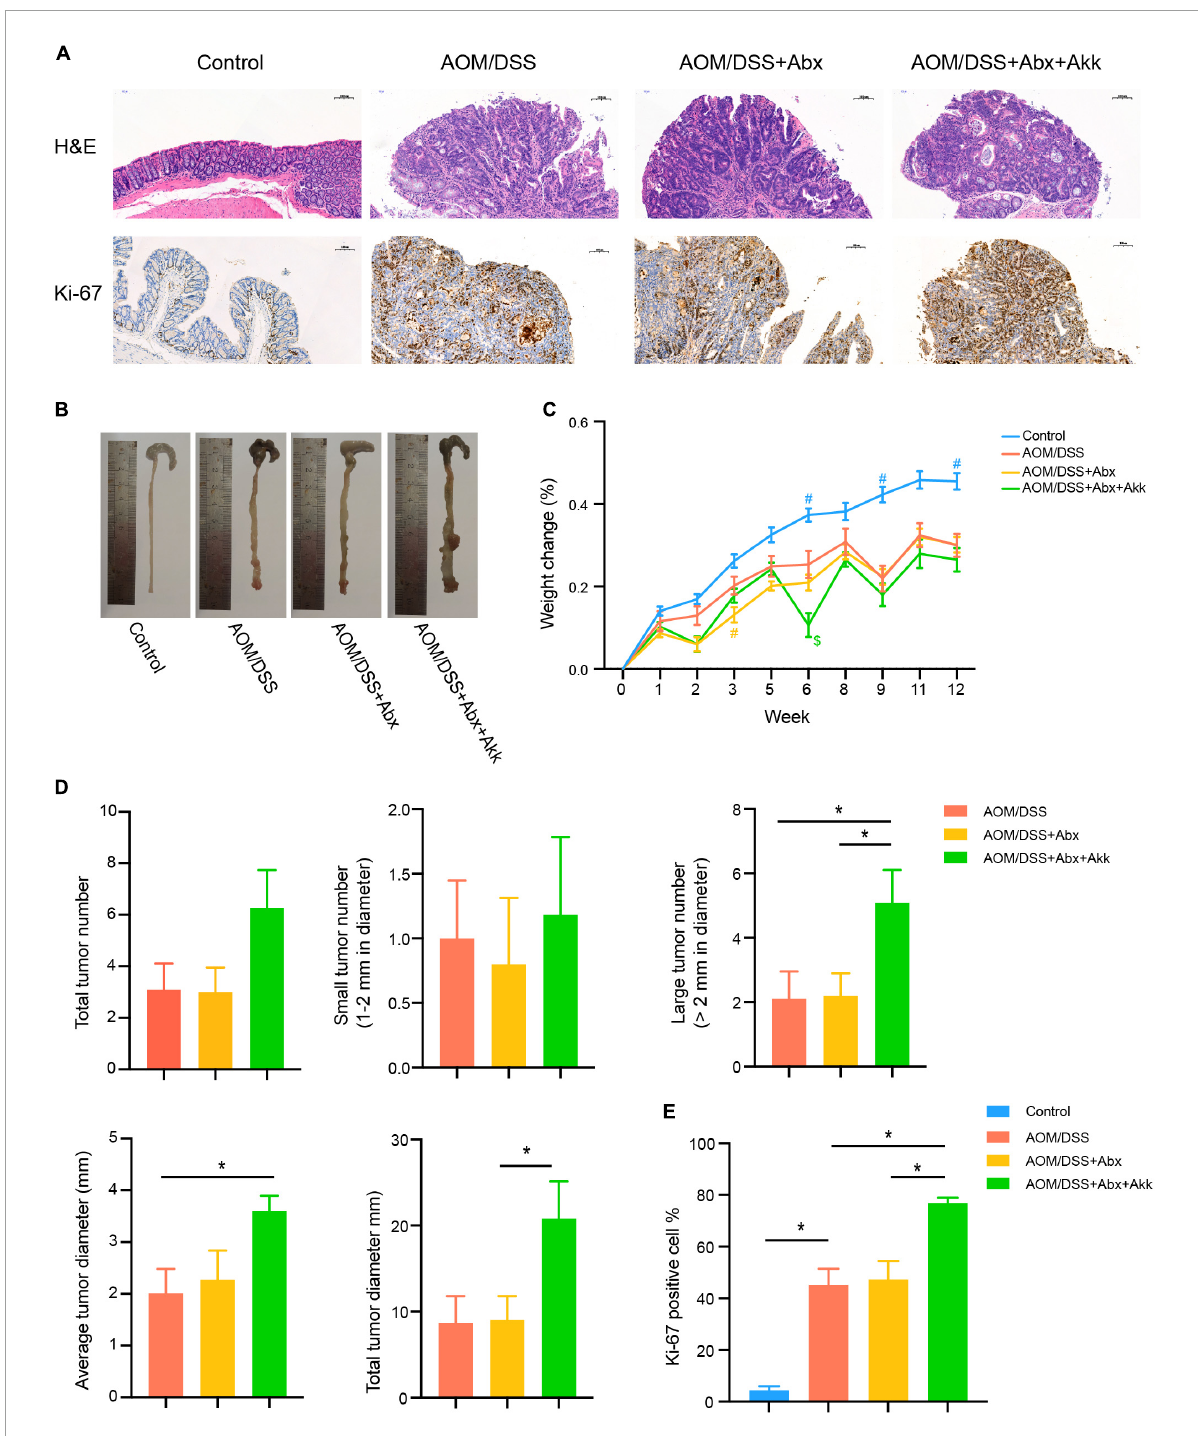
FIGURE2 Spontaneous recovery of the gut microbiome had no effect on the outcome of CAC, whereas post-antibiotic replenishment with Akkermansia muciniphila worsened the outcome of CAC. (A) Representative pathological H&E staining and Ki-67 protein immunohistochemical staining of colon tissues of the four groups. (B) Tumor development of the four groups. (C) Percentage of weight change from the baseline (week 0) to the end of the experiment (week 12). Data are shown as means ± SEM. The colors of “#” and “$” represent the corresponding groups, blue: Control; yellow: AOM/DSS + Abx; green: AOM/DSS + Abx + Akk. # P < 0.05, compared to the AOM/DSS group at the corresponding time point; $ P < 0.05, compared to the AOM/DSS + Abx group at the corresponding time point. (D) Assessment of tumor occurrence in the four groups: total tumor number, small tumor number (1–2 mm in diameter), large tumor number ( > 2 mm in diameter), average tumor diameter (mm), and total tumor diameter (mm). (E) Percentage of Ki-67 protein-positive cells in the four groups. Data are shown as means ± SEM. * P <